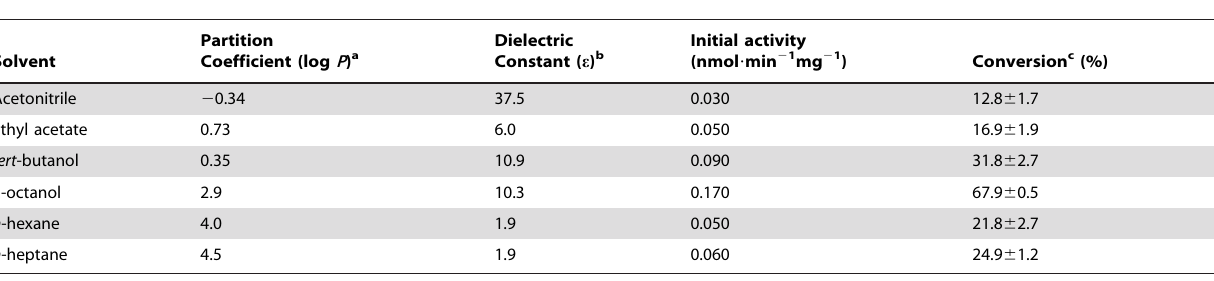
Table 2. Impact of co-solvents on the initial activity of the LipIAF5-2 WCB.